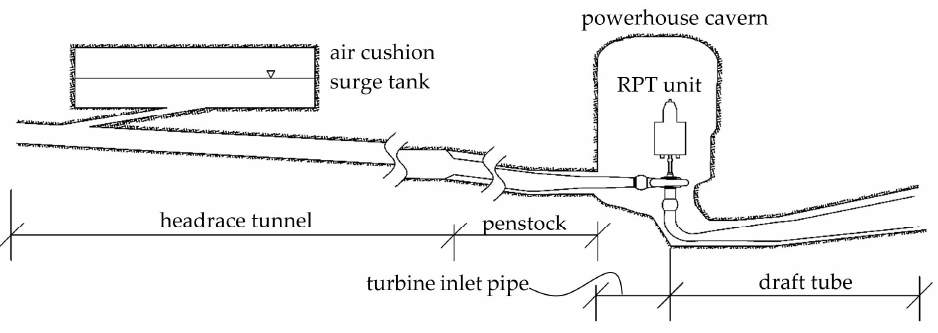
Figure 11. Jukla air cushion surge tank and powerhouse